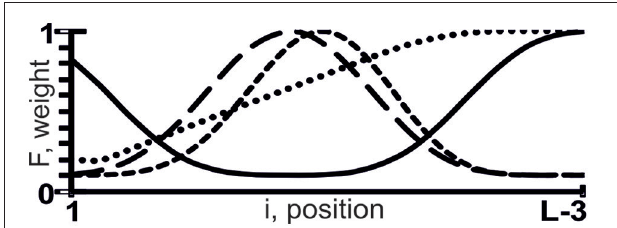
FIGURE 2 | Utility estimates (the y -axis), υ ( α ), for correlations between X({ ξ i }) and [z 1 z 2 z 3 z 4 ] F ({ ξ i }) based on statistical significance ( α , the x -axis) for the given